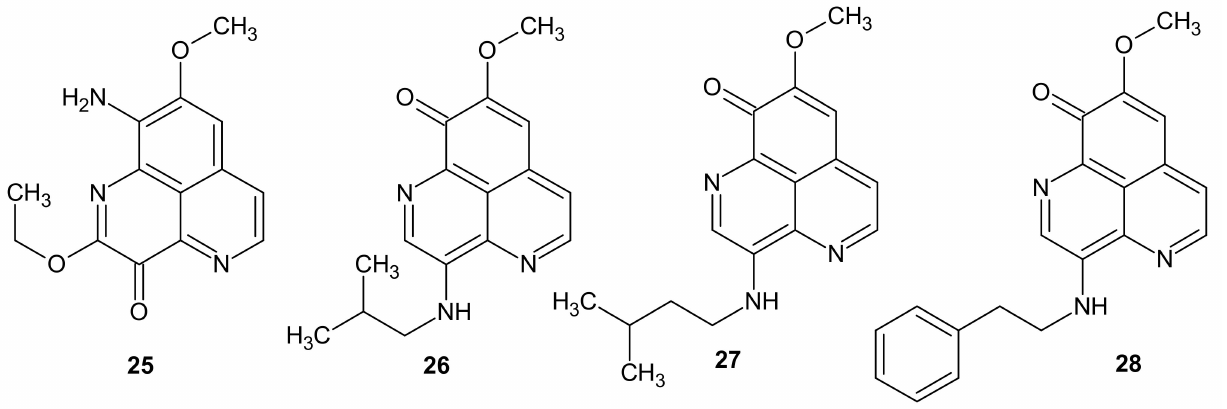
Figure 8. Structures of aaptamine derivatives 25 – 28 .